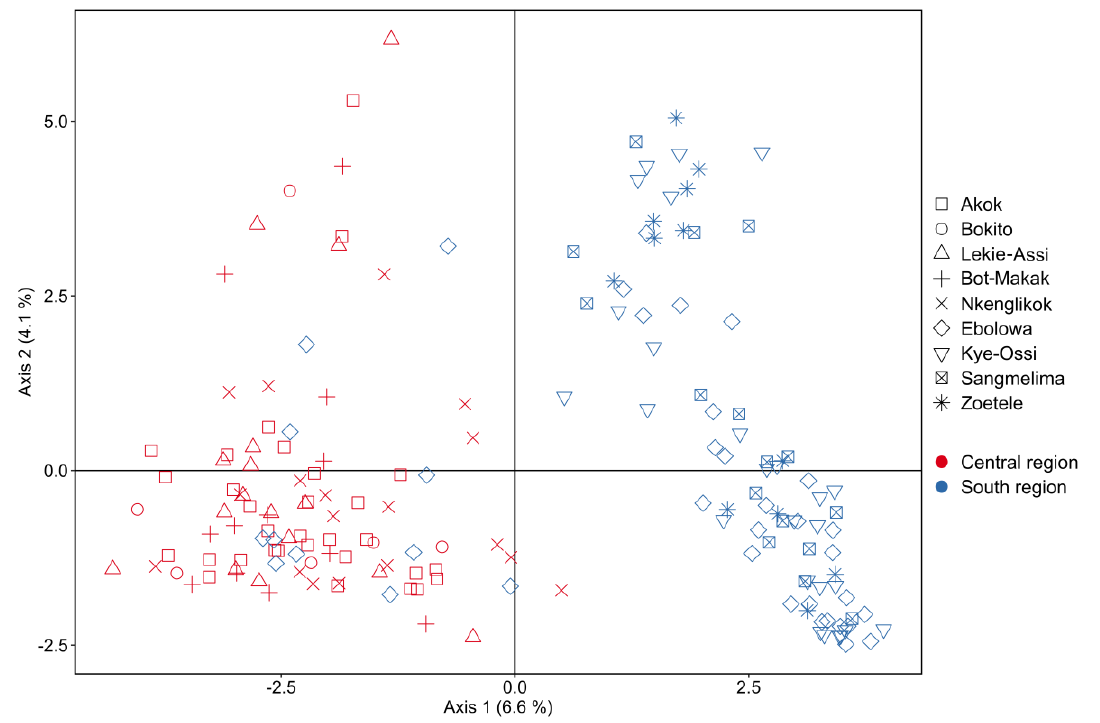
Figure 6. Principal component analysis of analysed individuals of G. kola based on AFLP markers (Central region: Akok, Bokito, Bot-Makak Lekiasi, Nkelikok; South region: Ebolowa, Kye-Ossi, Sangmelima, Zoételé).